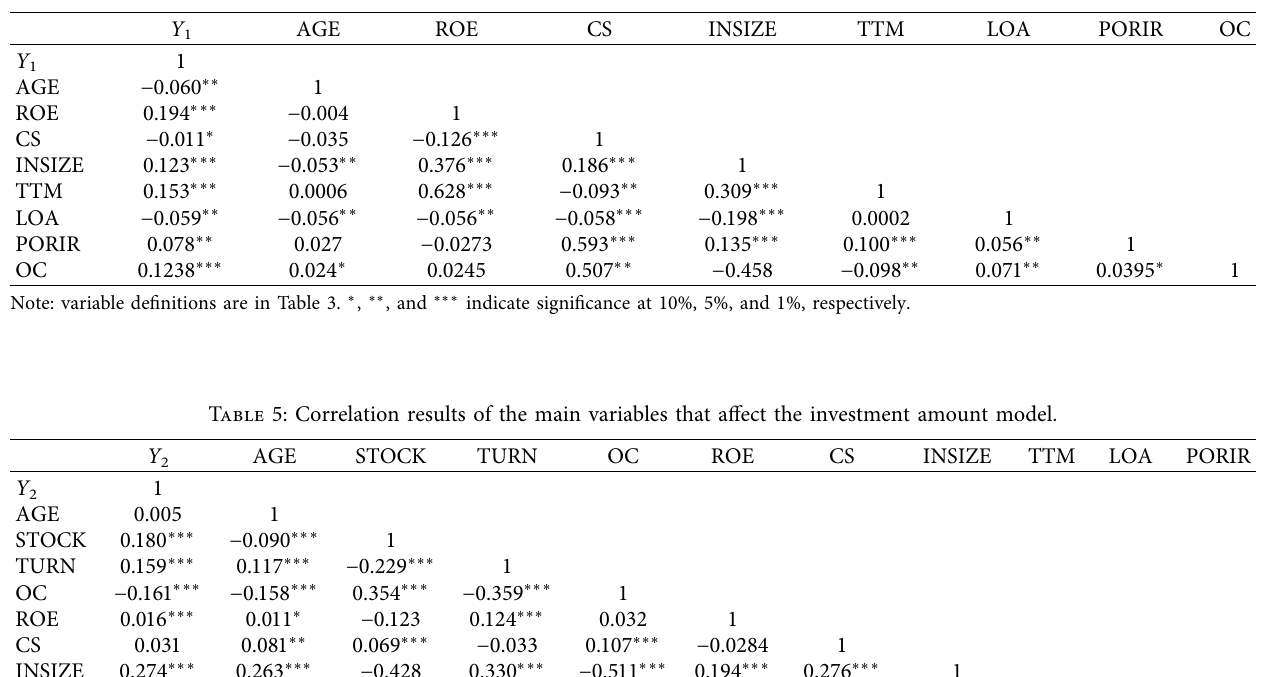
Table 4: Correlation results of the main variables in the investment model.